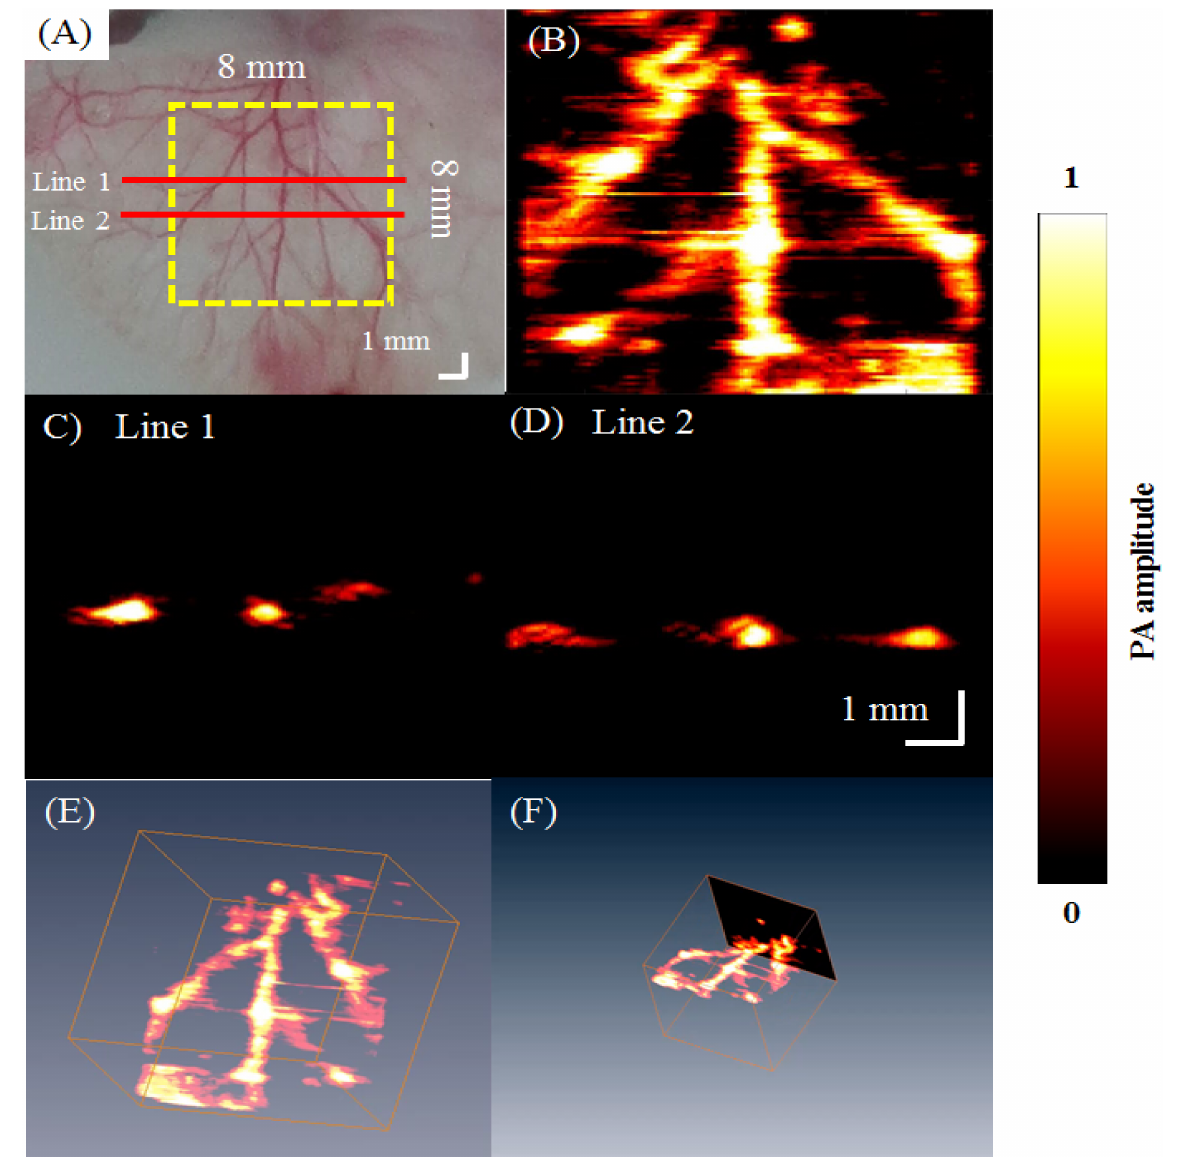
Figure 10. In vivo PA imaging of rat ear vasculature. ( A ) Image of the blood vessels scanned; ( B ) PA C-scan image; ( C , D ) PA B-scan images obtained for Lines 1 and 2 shown by the red solid lines in ( A ); ( E , F ) 3D PA images (Videos S3 and